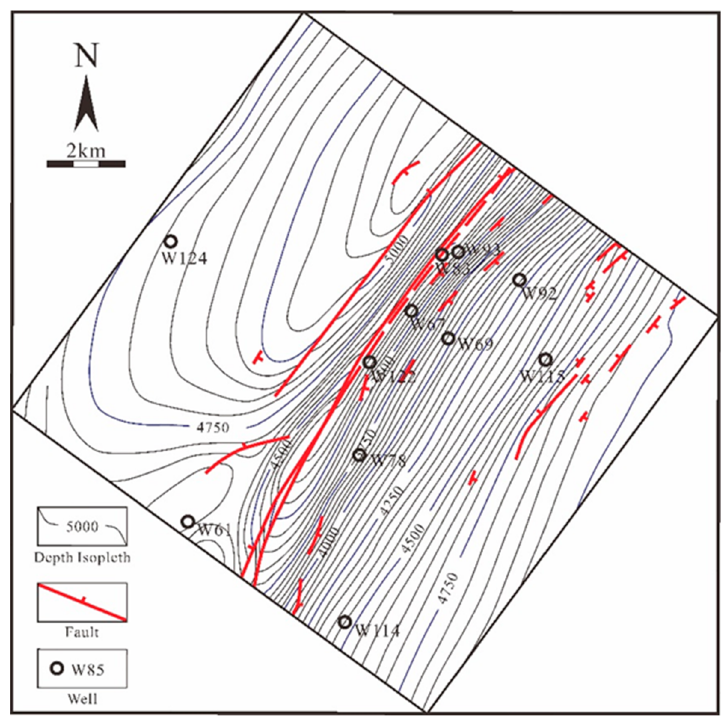
Figure 12. Tectonic reflection burial depth map of Maokou Formation in the study area.